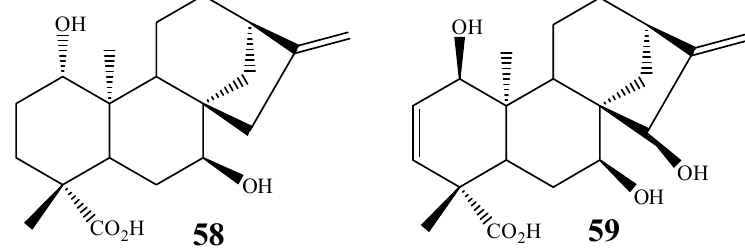
Figure 14. Chemical structures of kaurane diterpenes 58 and 59 bearing a C-1 hydroxyl group as a result of biotransformations.